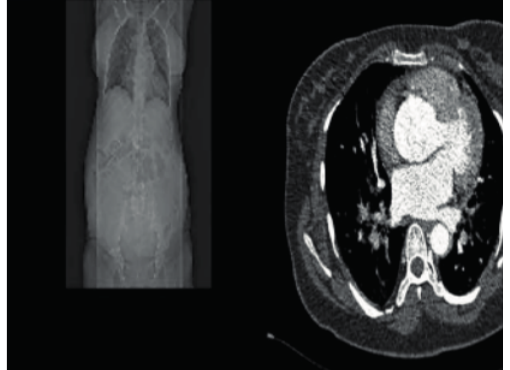
Figure 1: Computerised tomography angiography of the patient revealing a massive type A aortic dissection of the thoracic aorta extending proximally from the aortic root to proximal arch with extension into proximal innominate